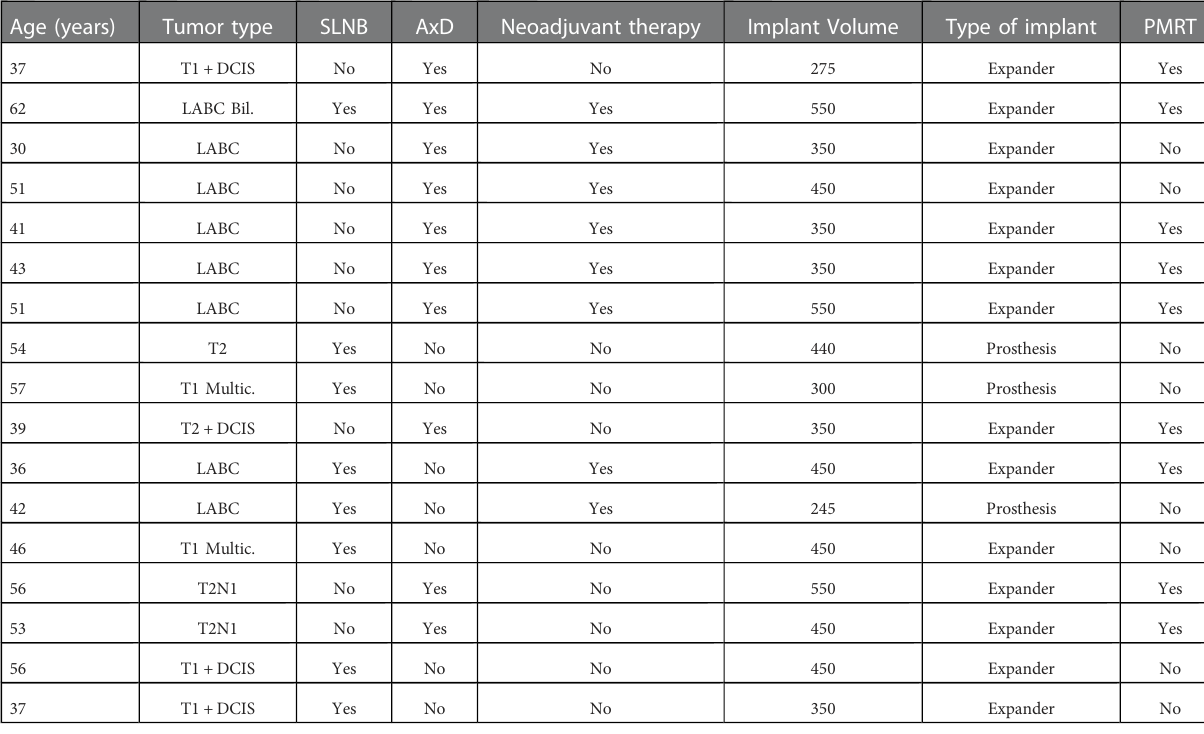
TABLE 1 Main characteristics of patients submitted to superomedial pedicle skin-reducing